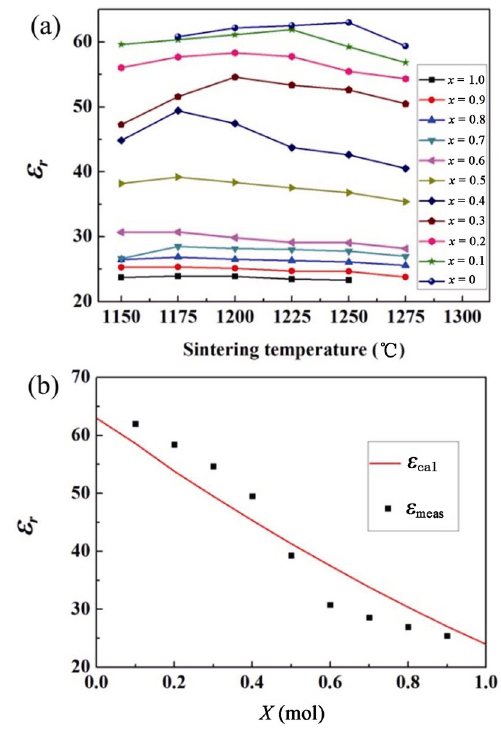
Fig. 7 (a) Dielectric constants of (1– x )CoTiNb 2 O 8 – x ZnNb 2 O 6 ceramics as a function of sintering temperatures, and (b) the change of dielectric constants of (1– x )CoTiNb 2 O 8 – x ZnNb 2 O 6 ceramics vs. x